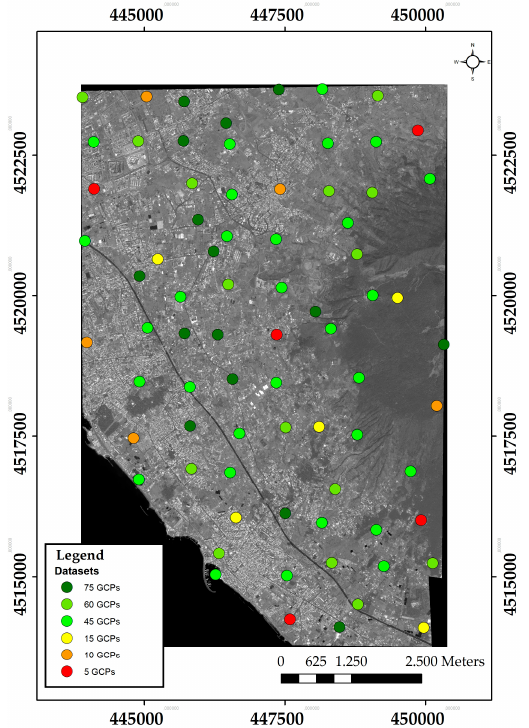
Figure 5. All GCP datasets (5-10-15-45-60-75) distribution in WV-2 primary panchromatic image. The